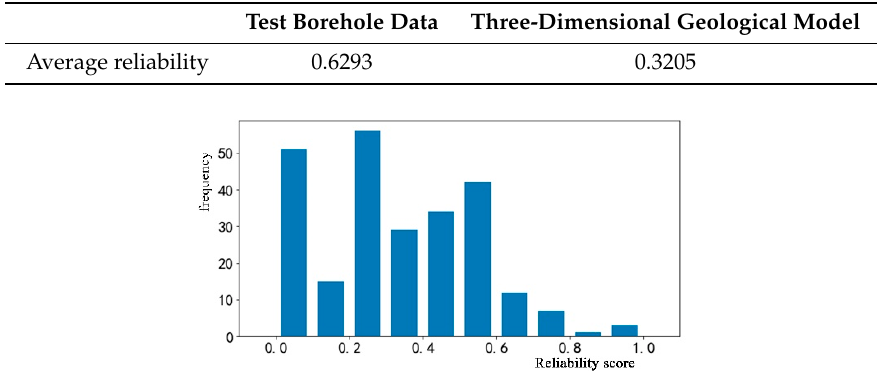
Table 12. Average reliability of the test borehole data and 3D geological model.